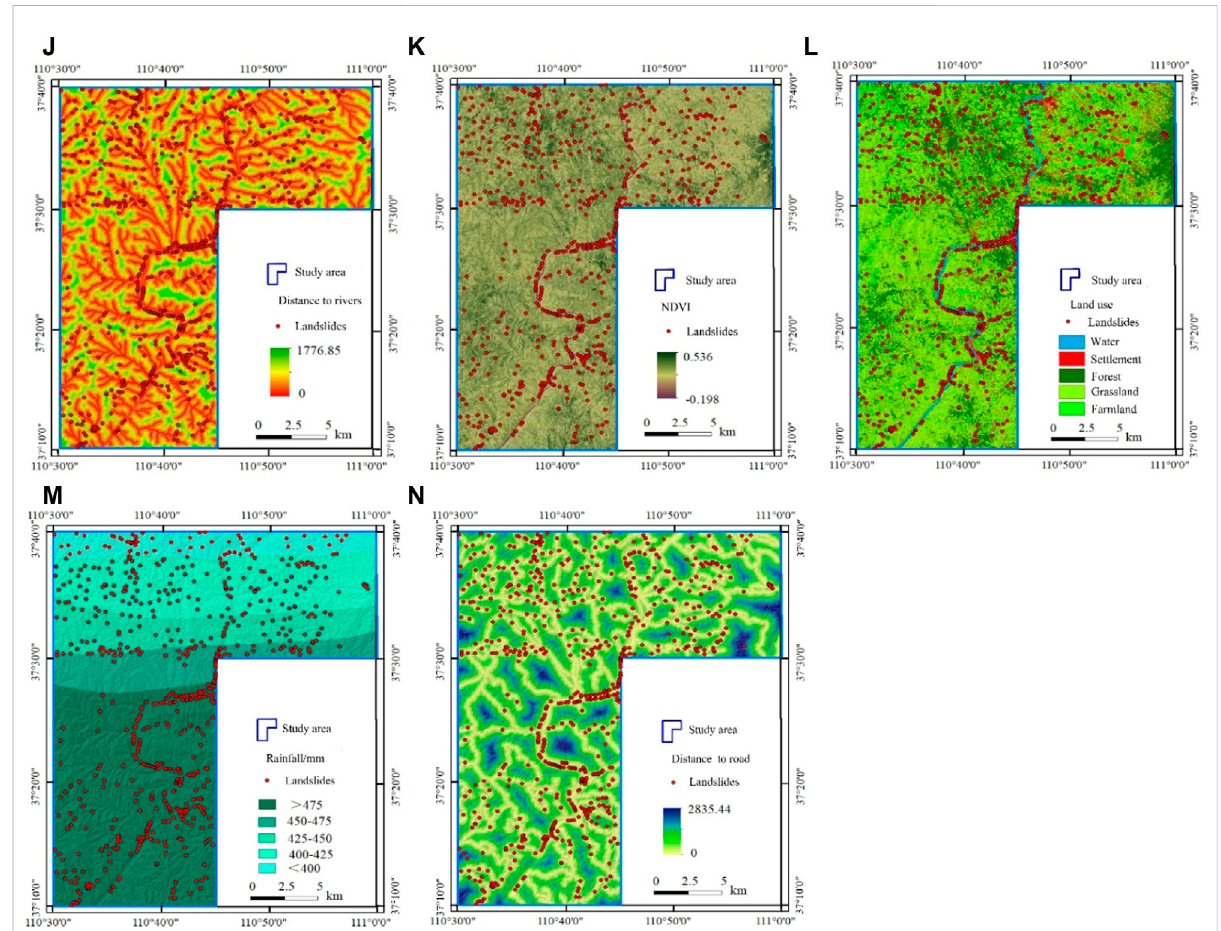
NDVI (Figure 4K): NDVI reveals the greenness degree of a speci fi c area and can in fl uence hydrological processes on slopes. It was also obtained from the RS images. The equation is as follows (Chang et al., 2020):